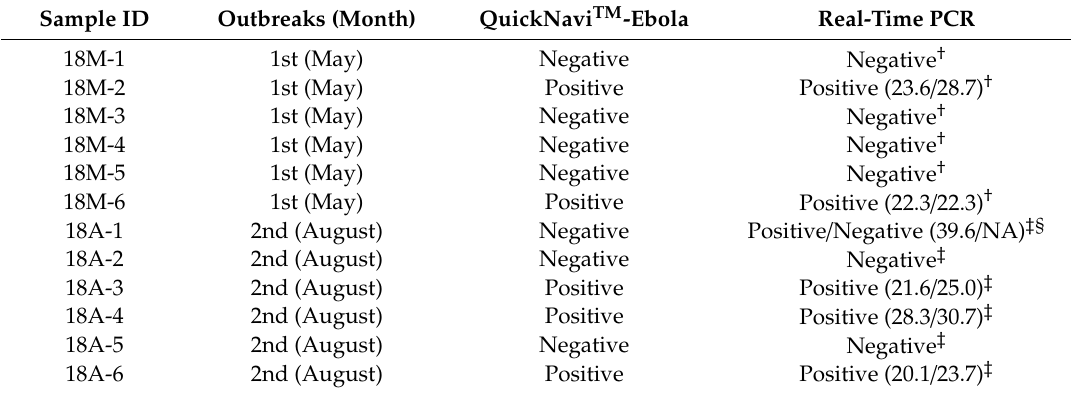
Table 1. Diagnosis of initial Ebola virus disease (EVD) cases in the two 2018 outbreaks in the Democratic Republic of the Congo